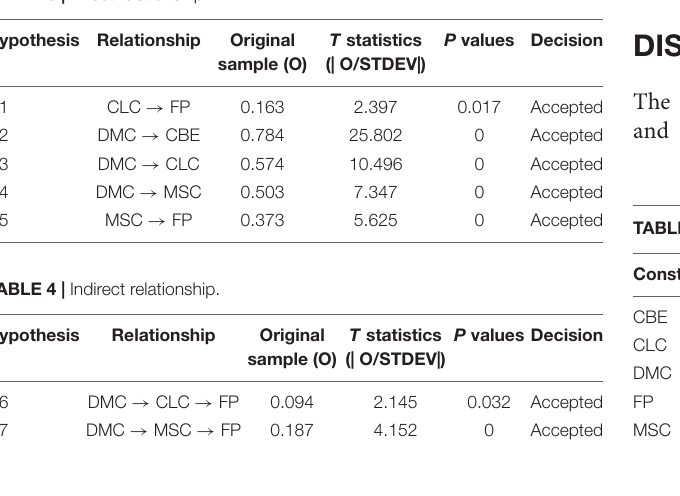
Table 4 ; Chinakidzwa and Phiri, 2020b).